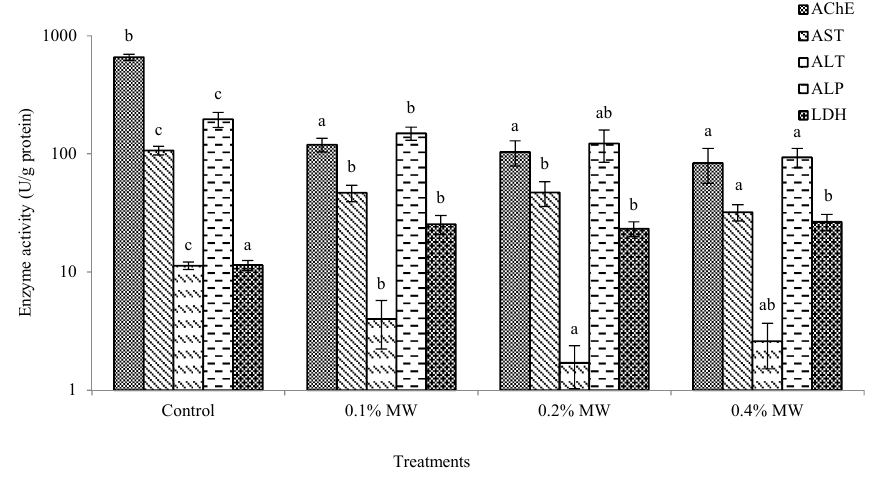
Fig. 1. Enzyme activities in entire body of galba truncatula exposed to 0.1%, 0.2%, and 0.4% of municipal wastewater for 14 days